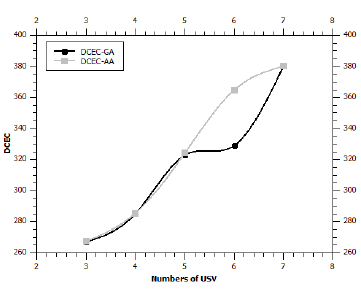
Figure 20: Total energy consumption in a zone with a strong degrees of dirt.